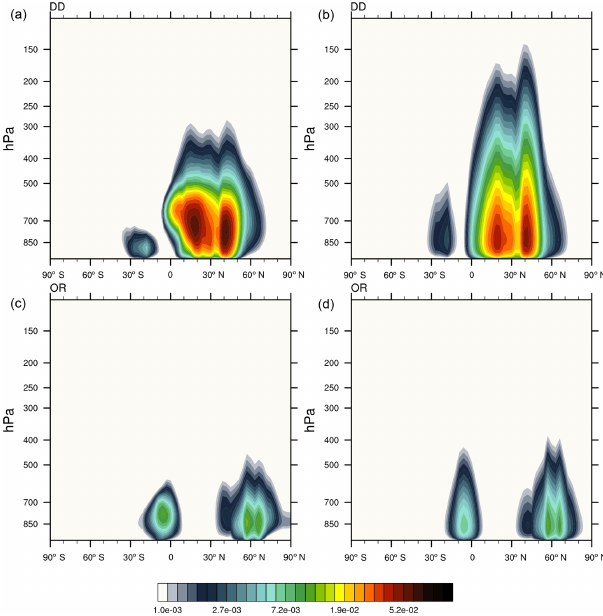
Figure 3. Zonal-mean layer-integrated mass profiles (in grams per square metre) average for July, weighted by the total integrated mass at every grid point for (a, b) mineral dust and (c, d) organic matter. Panels (a) and (c) show the zonal mean from CR fields, and (b) and (d) show the vertical profiles computed using an exponential function applied to the total integrated mass (see text). The scale height used for dust is 3km, while for organic matter it is